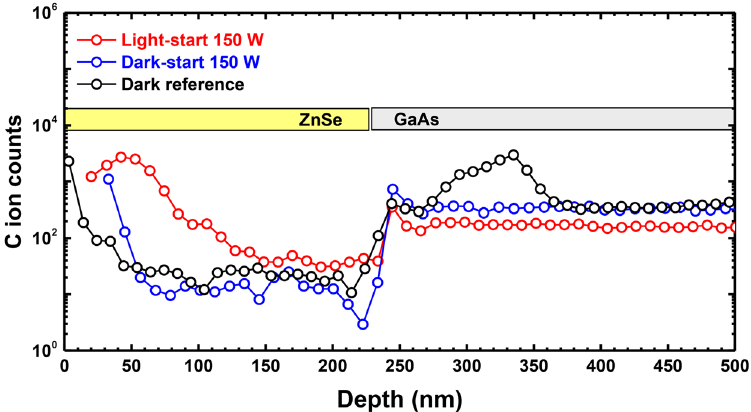
Figure 7. Cross-sectional carbon profile of light-start, dark-start and dark reference samples obtained by SIMS. For the light-stimulated samples, the Xe lamp power was 150 W. There is no significant difference among the samples in cross-sectional carbon ion counts.